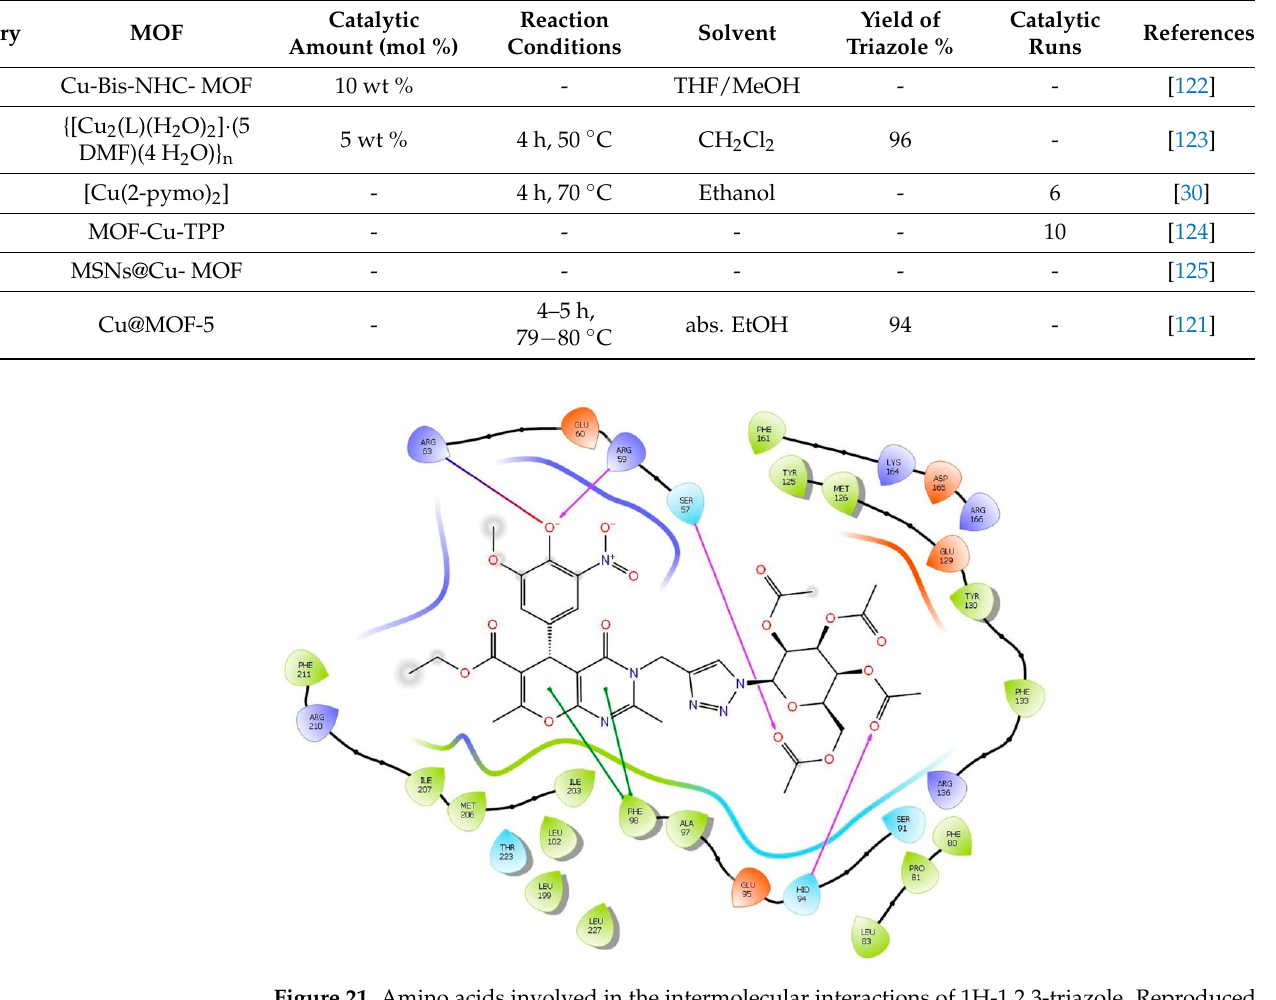
Figure 21. Amino acids involved in the intermolecular interactions of 1H-1,2,3-triazole. Reproduced from [121] with permission from Elsevier, copyright year: 2019. Table 7. Copper-based MOFs for the synthesis of 1,2,3-triazole via the CuAAC reaction.